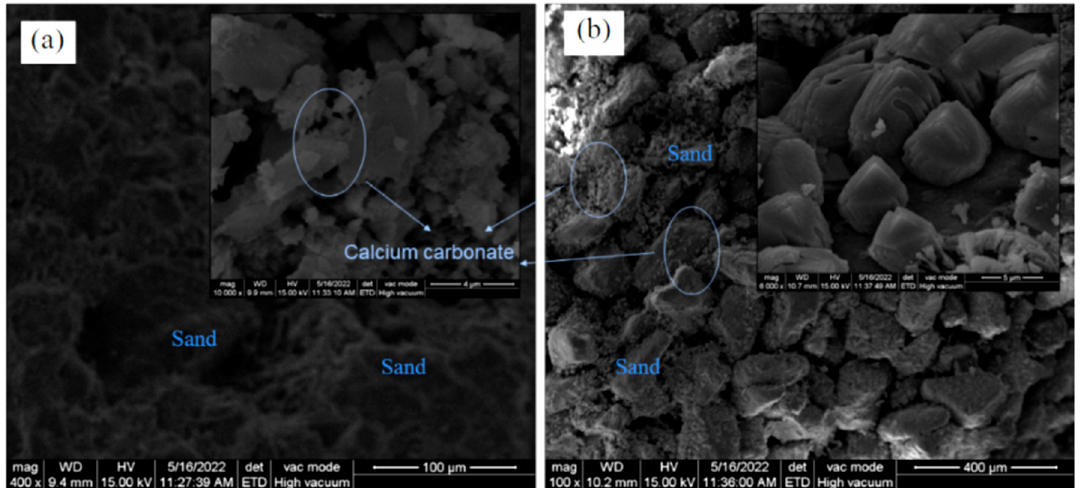
Figure 5. ESEM images of CaCO 3 induced by different calcium sources: ( a ) calcium chloride (400 × and 10,000 × magnification) and ( b ) limestone (100 × and 6000 × magnification).